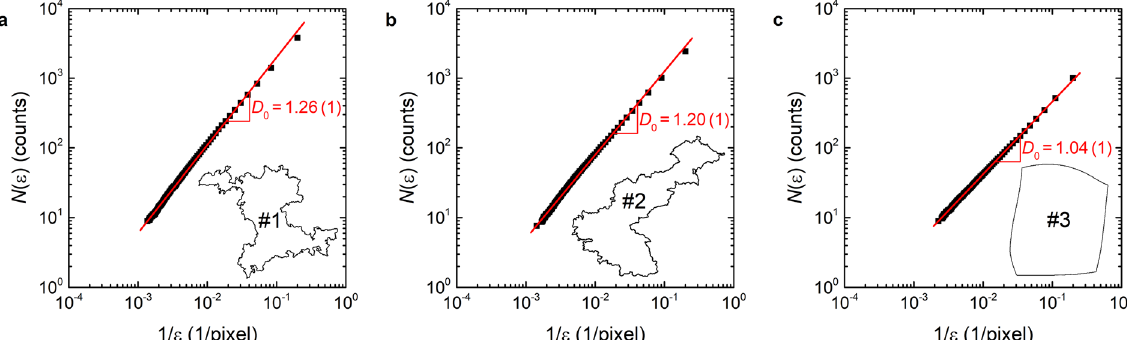
Figure 2. Evaluation of the box-counting fractal dimension D 0 , extracted from log-log plots of the number of boxes N ( ε ) versus the inverse box side length 1/ ε . The red lines represent least-squares fits of straight lines to the data points (black squares), the slopes of which yield D 0 values for ( a ) grain #1 and ( b ) grain #2 in Fig. 1(b) and ( c ) grain #3 in Fig.